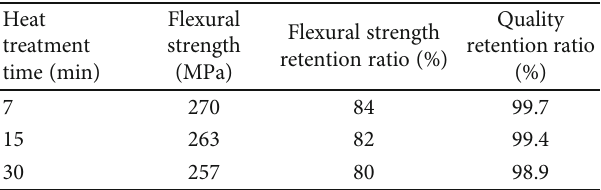
Table 5: E ff ect of thermal treatment at 500 ° C on mechanical property of MDPES-2 composites.